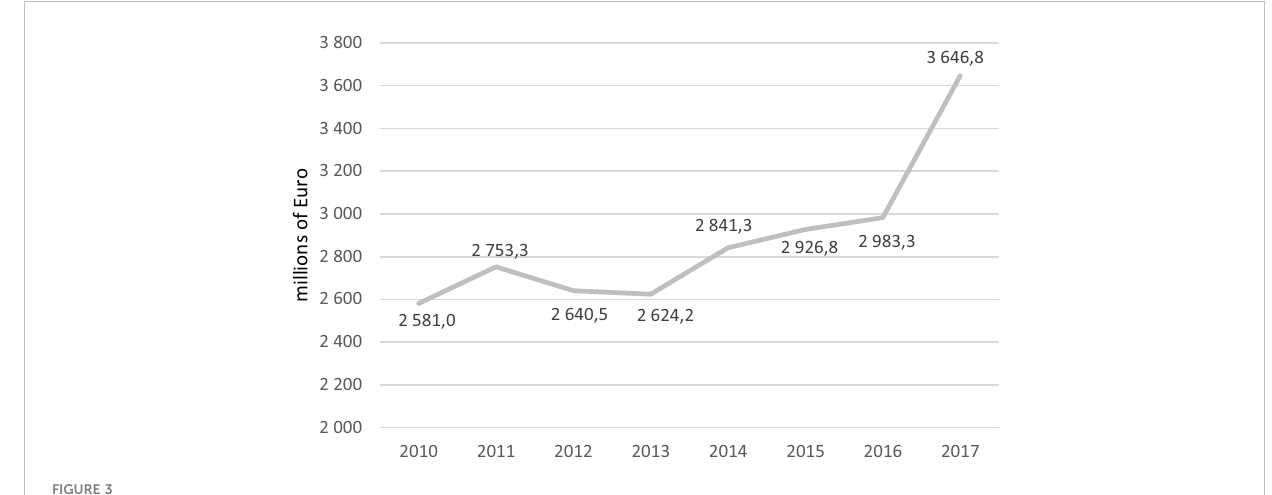
FIGURE 3 The size of the Polish blue economy in 2010 – 2017. Source: own elaboration.